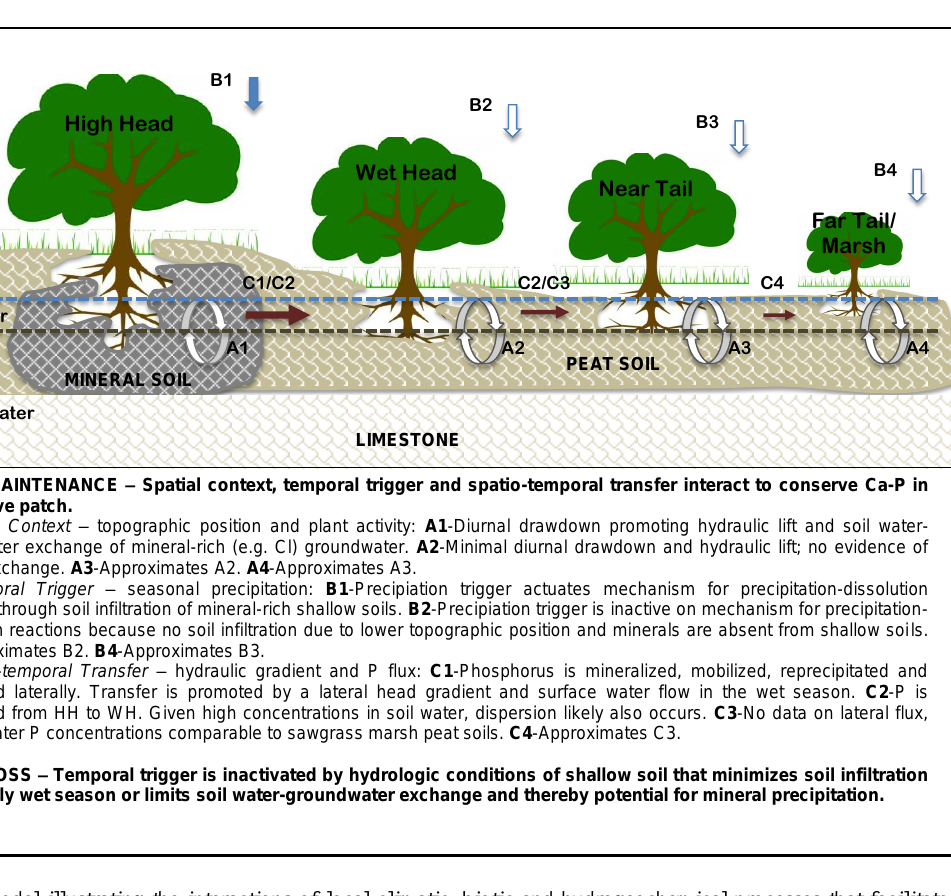
Fig. 6. Conceptual model illustrating the interactions of local climatic, biotic and hydrogeochemical processes that facilitate phosphorus dynamics along an Everglades tree island forest-marsh